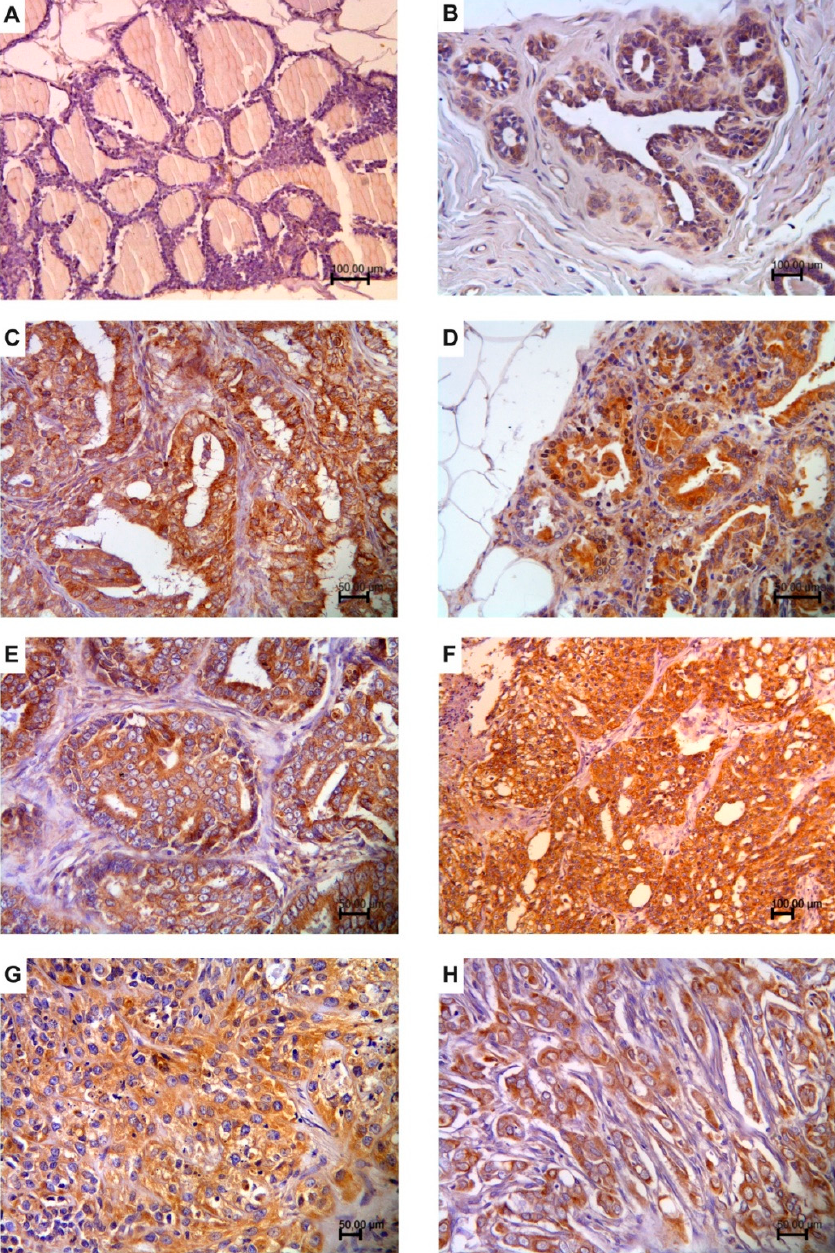
Figure 1. p62 immunostaining in the non-neoplastic feline mammary gland and mammary carcinoma (immunoperoxidase stain; hematoxylin counterstain). ( A ) Normal cat mammary gland negative for p62; ( B ) normal cat mammary gland slightly positive for p62; ( C ) low-grade (GI) feline mammary carcinoma with intense cytoplasmic immunolabeling; ( D ) low-grade GI feline mammary carcinoma with finely granular intense cytoplasmic immunolabeling; ( E ) intermediate-grade (GII) feline mam- mary carcinoma with intense cytoplasmic immunolabeling; ( F ) high-grade (GIII) feline mammary carcinoma with coarsely granular intense cytoplasmic immunolabeling; ( G ) high-grade (GIII) feline mammary carcinoma with intense granular cytoplasmic immunolabeling; ( H ) high-grade (GIII) feline mammary carcinoma with lymphovascular invasion and intense cytoplasmic